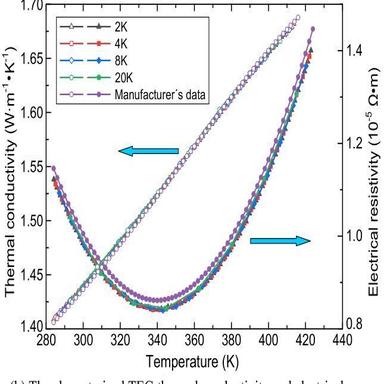
The characterized TEG parameters when the temperature Th rises stepwise at various temperature intervals.